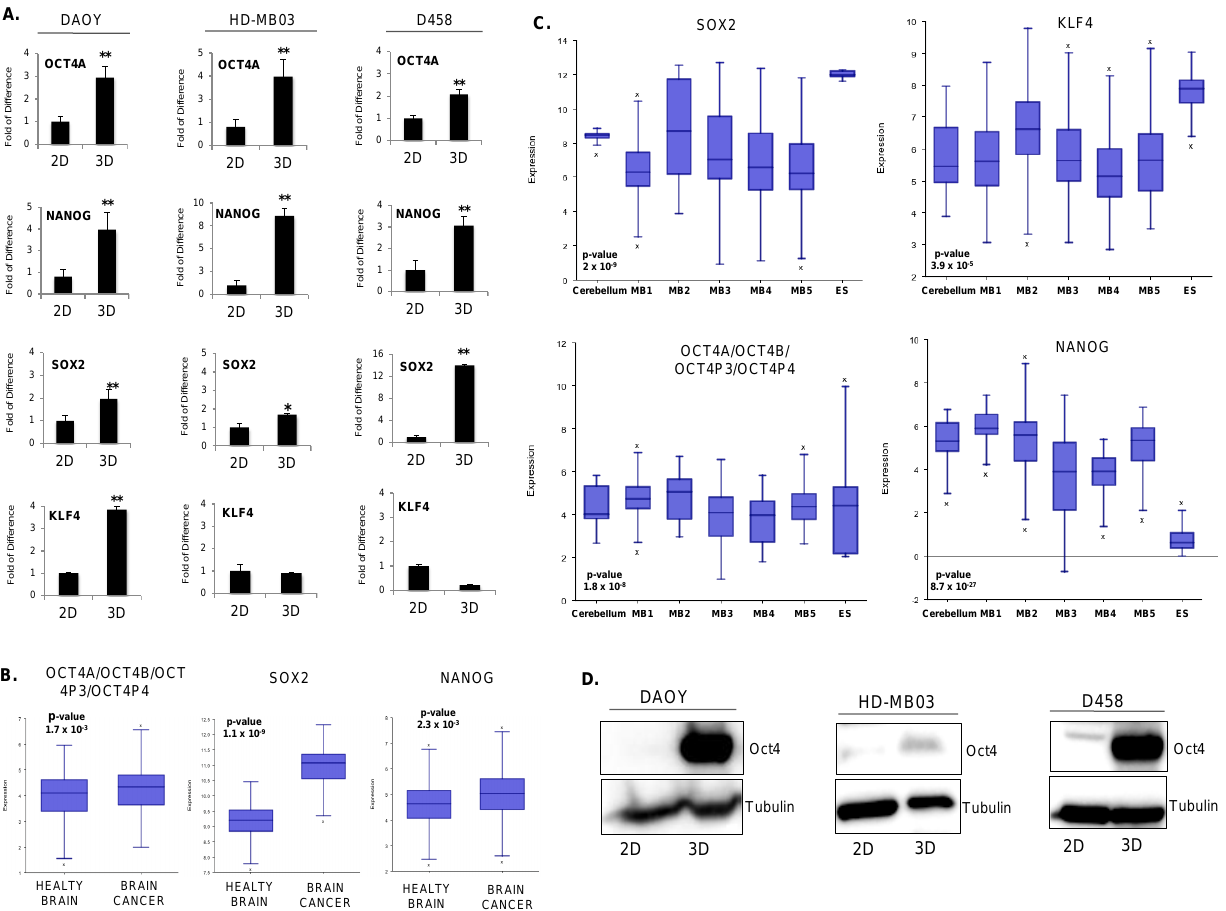
Figure 2. Pluripotent regulatory network in MB tumorsphere(s). ( A ) qPCR analysis of pluripotent transcription factors OCT4A, NANOG, SOX2, and KLF4 in spheres (3D) generated from DAOY, HD-MB03, and D458 lines relative to adherent counterpart (2D). * p < 0.05; ** p < 0.01; according to two-tailed paired Student’s t-test. Data are the mean ± SD. ( B ) Box–dot plot showing the expression level of OCT4A/OCT4B/OCT4P3/OCT4P4, SOX2, and NANOG in healthy brain and brain cancer. p < 0.001, according to one way analysis of variance (ANOVA). Data are the mean ± SD. ( C ) Box–dot plot showing the expression level of SOX2, KLF4, OCT4A/OCT4B/OCT4P3/OCT4P4, and NANOG in healthy cerebellum (cerebellum n = 9 from Roth database) and MB patients (M1: (n = 76) Gilbertson database, M2: (n = 51) from de Boer database, M3: (n = 223) from Pfister database, M4: (n = 57) from Delattre database, M5: (n = 62) from Kool database and embryonic stem cells, ES: Neuronal embryonic stem cells (n = 6) from Viale database). p < 0.001, according to One way analysis of variance (ANOVA). Data are the mean ± SD. ( D ) Western blot analysis showing the protein level of OCT4 in adherent (2D) and spheroid (3D) cells for each cell line as indicated. Tubulin expression level was used as a loading control. The original blots could be found in the Figure